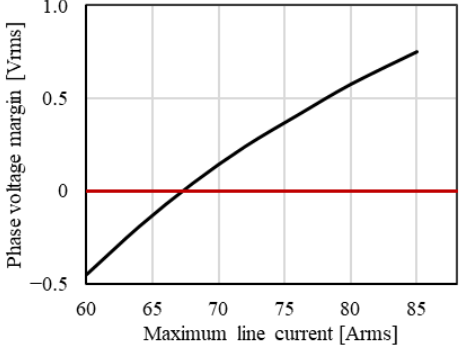
Figure 8. Phase voltage margin.